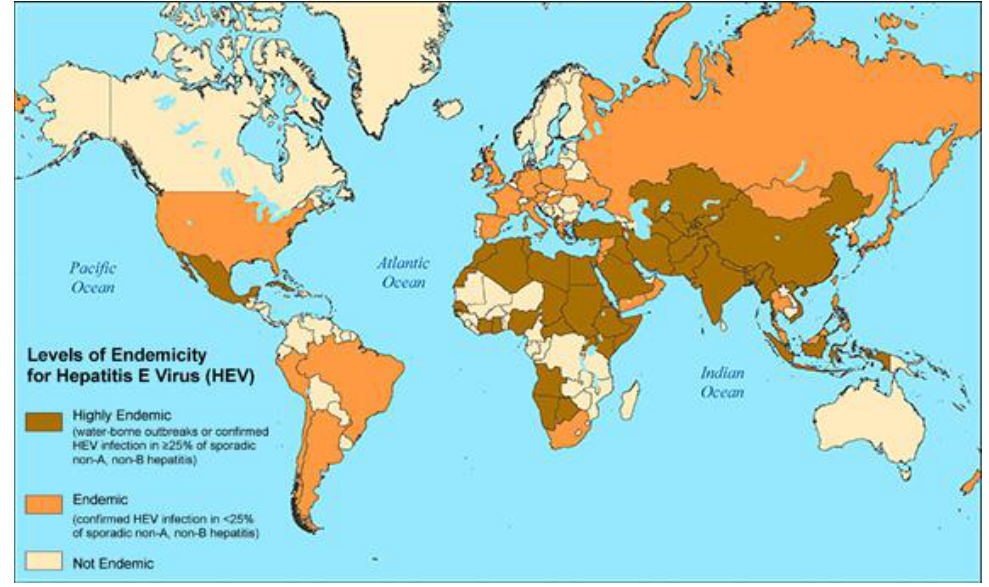
Figure 5. Global prevalence of HEV [70]